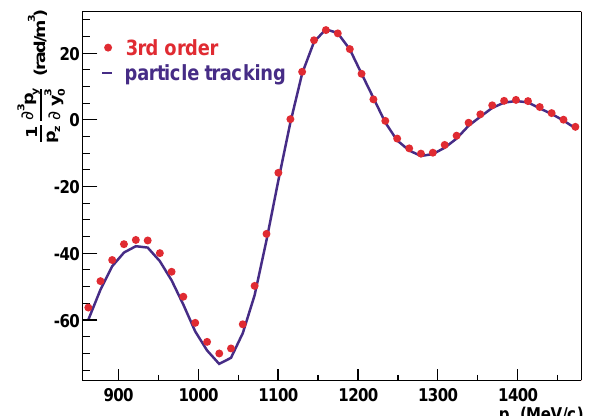
FIG. 6. (Color) Total octupole strength of a 90 ± HDSM dipole calculated by particle tracking and by perturbation theory using differential